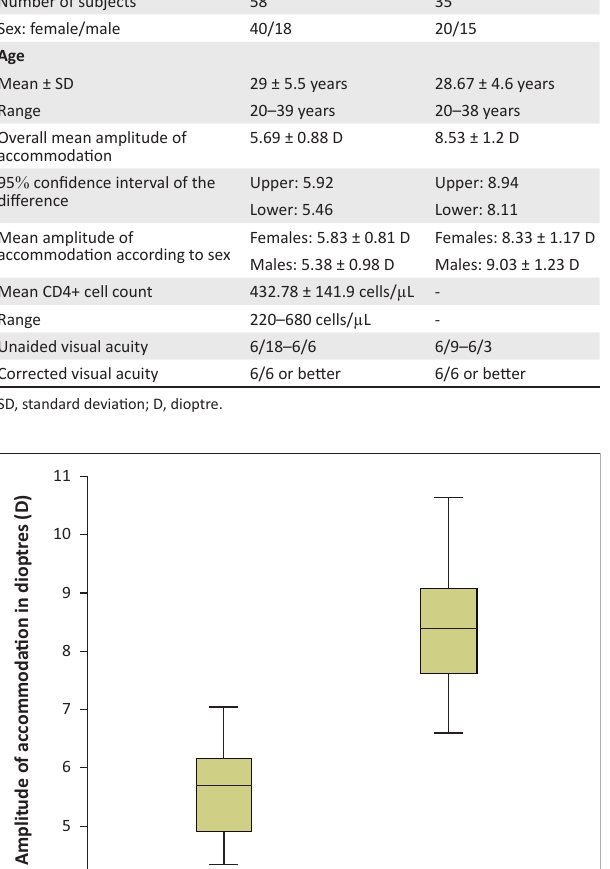
TABLE 1: Descriptive statistics of subjective amplitudes of accommodation in dioptres. Variable